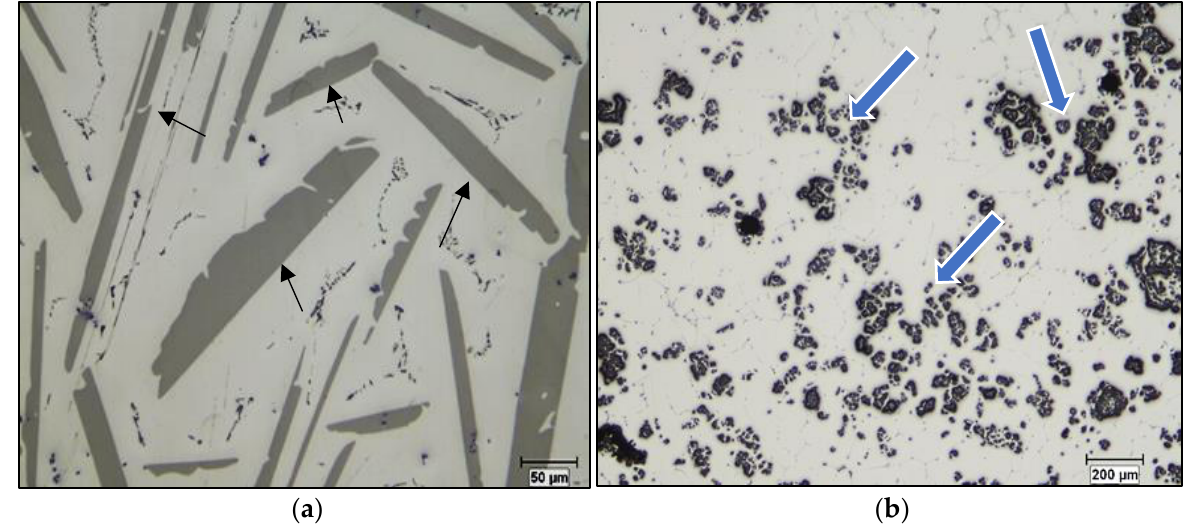
Figure 3. Optical micrographs showing the distribution of: ( a ) Al 3 Ti (black arrows) and ( b ) AlB 2 particles (blue arrows) in Al-10%Ti and Al-4%B master alloys, respectively.